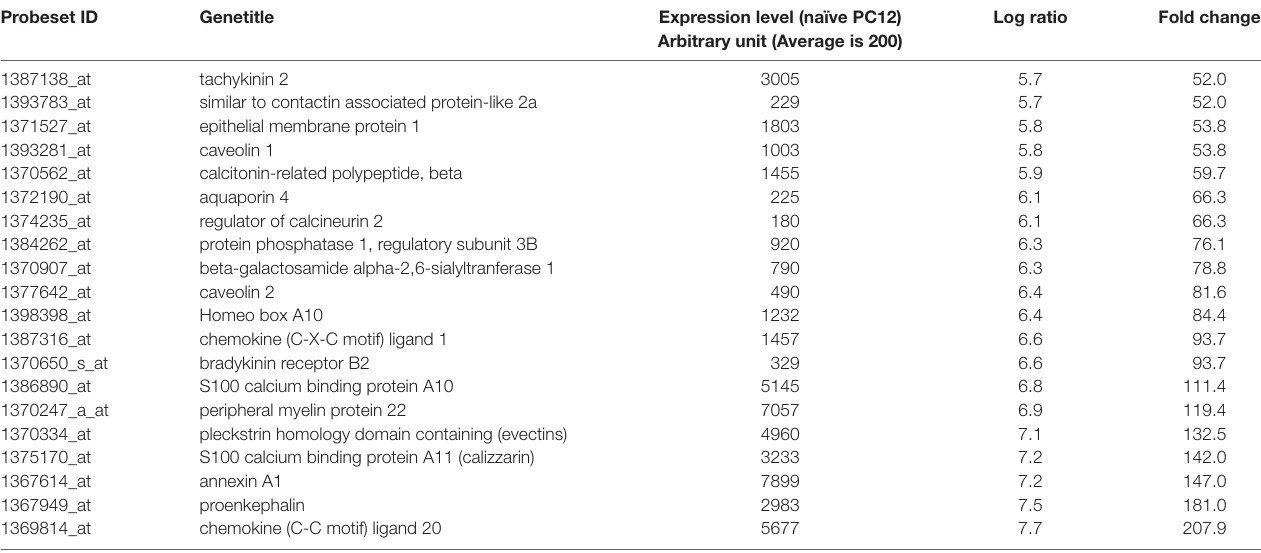
TABLE 2 | Global gene expression is significantly affected by MKP3 expression. Probeset